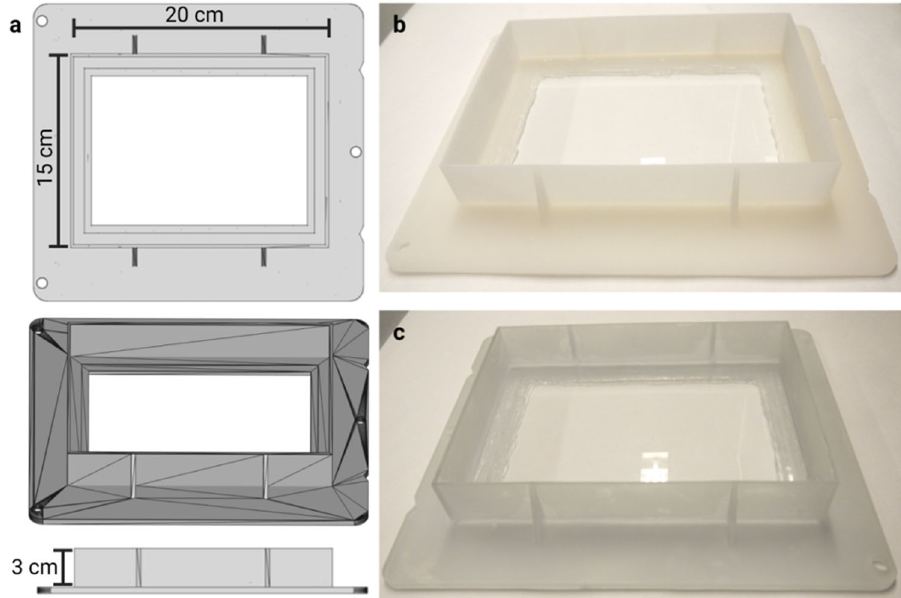
Fig. 8 3D printed imaging chambers for large, cleared samples. a 3D rendering of the larger imaging chamber used routinely on the ct-dSPIM set-up. The chambers have a volume on 0.9 l (20 cm × 15 cm × 3 cm). Chamber is shown in top view (top), oblique (middle), and side view (bottom). b Chamber are sealed with silicon to prevent the chamber from leaking